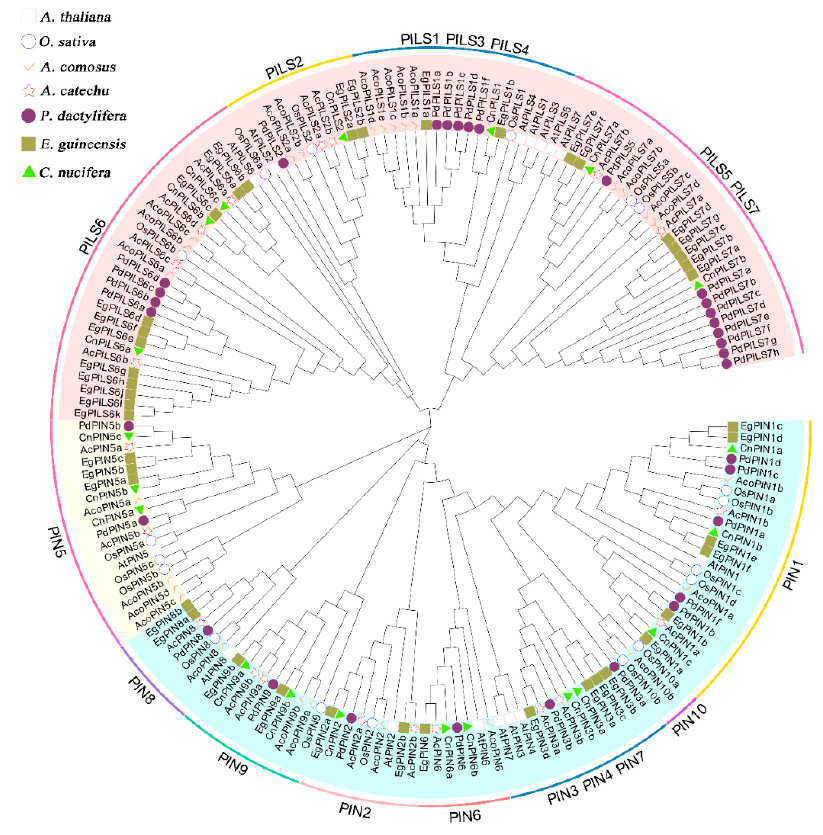
Figure 1. Phylogenetic analysis of PILS and PIN proteins from A. catechu (Ac), Arabidopsis thaliana (At), Oryza sativa (Os). Ananas comosus (Aco), Cocos nucifera (Cn), Elaeis guineensis (Eg), Phoenix dactylifera (Pd). Different PIN/PILS subfamilies are represented by different colors, and the different shapes represent different species.